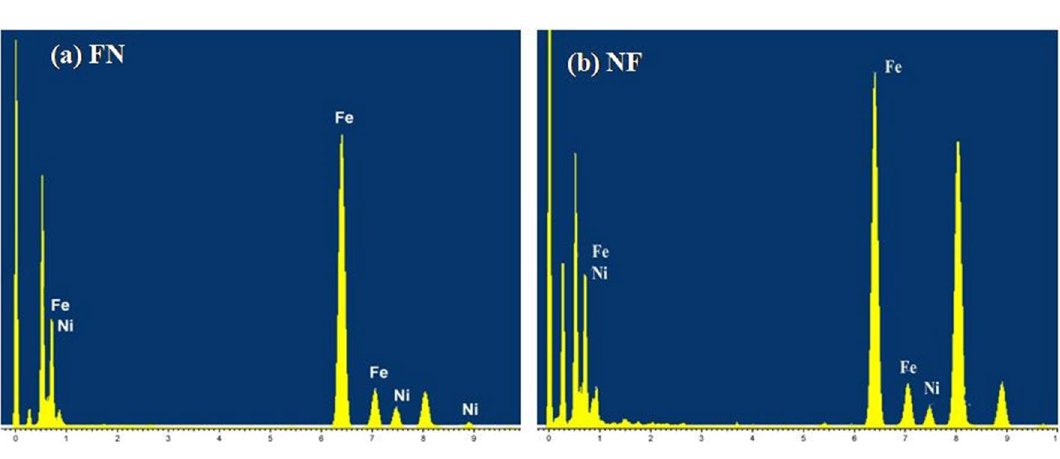
Figure 2. ( a,b ) Elemental analysis of CS nanostructures ( a ) FN and ( b )